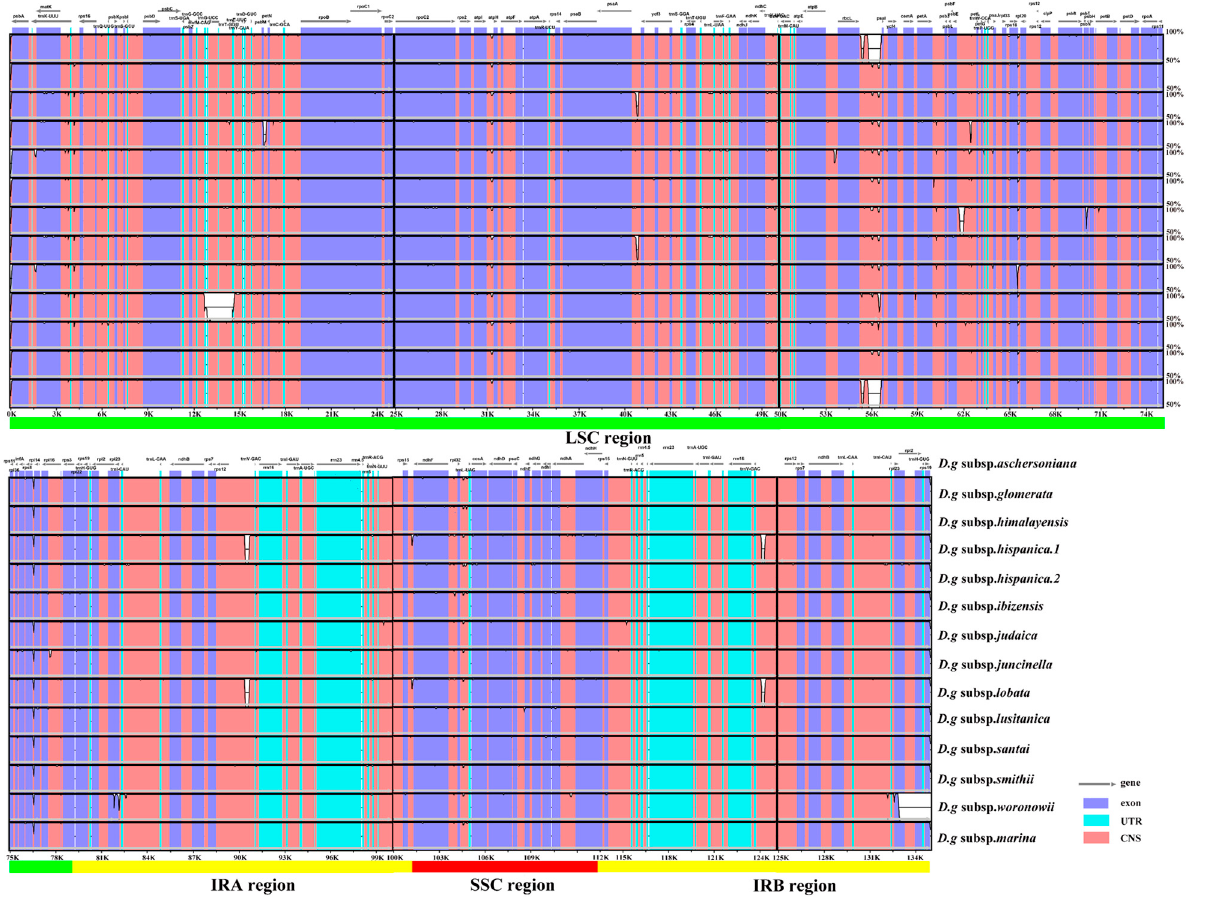
Figure 2. Sequence identity plot for cp genomes of Dactylis subspecies with D.g subsp. aschersoniana , as reference visualized by mVISTA. The gray arrows indicate the orientations of genes, the red blocks represent the intergenic region, the purple blocks represent exons, the blue blocks represent untranslated regions (UTRs), and the Y–axis represents the percent identity within 50–100%.